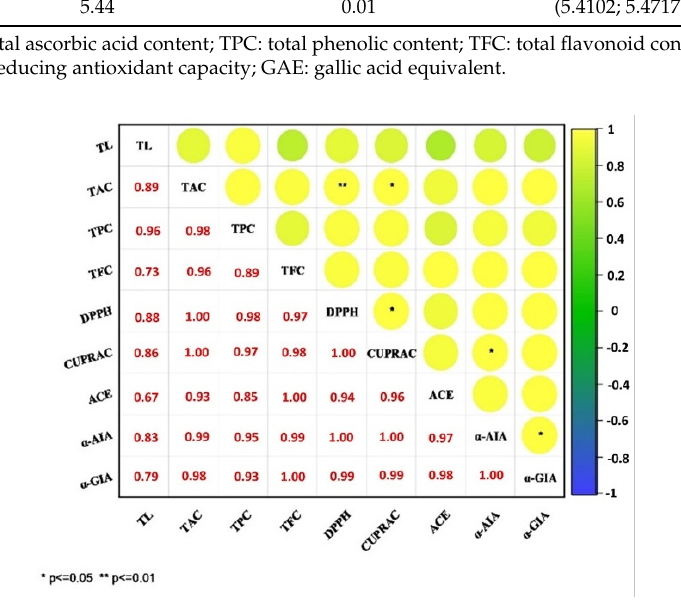
Figure 1. Response surface plots (3D) for TL ( A ), TAC ( B ), TPC ( C ), TFC ( D ), DPPH ( E ) and CUPRAC ( F ) analysis as a function of significant interaction factors for RSM and ANN.